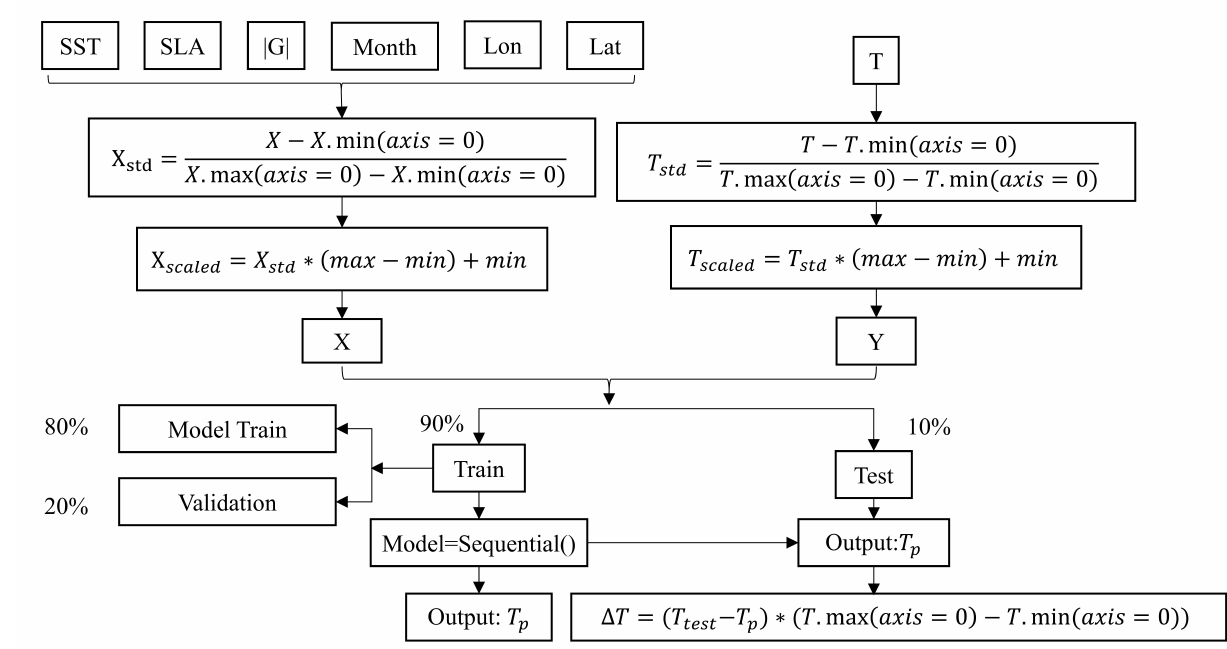
Figure 4. Flowchart of the data processing and reconstruction model